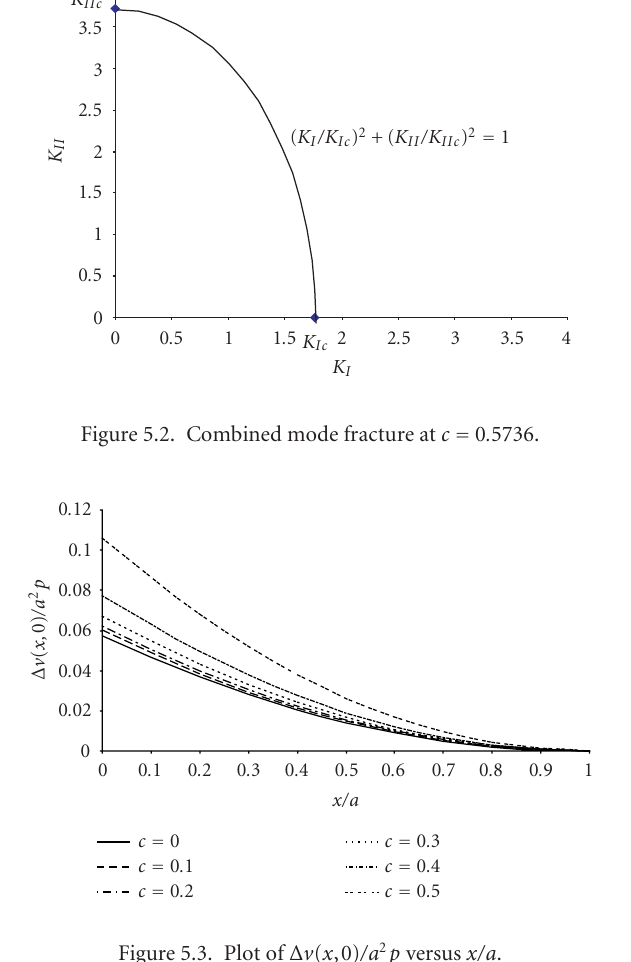
Figure 5.3. Plot of ∆ v ( x ,0) /a 2 p versus x/a